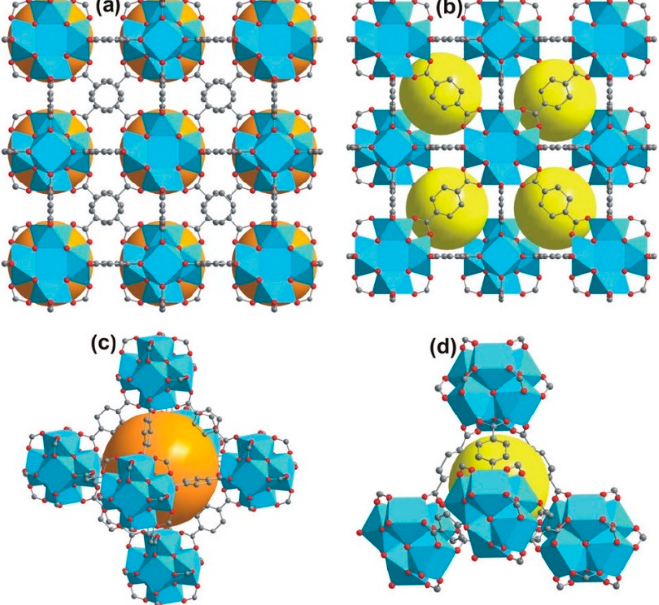
Figure 2. Ball-and-stick representations of the 3D cubic framework structure of UiO-66 ( a , b ). Parts of the framework showing spatial arrangements of the octahedral and the tetrahedral cages are represented by orange and yellow spheres, respectively ( c , d ). Magnified views of the octahedral and tetrahedral cages of Zr atoms are displayed as Zr (blue polyhedral), O (red spheres), and C (gray spheres). The hydrogen atoms and guest molecules have been removed from all the structural plots for clarity. Reprinted with permission from [76]. Copyright © 2013, Royal Society of Chemistry. All rights